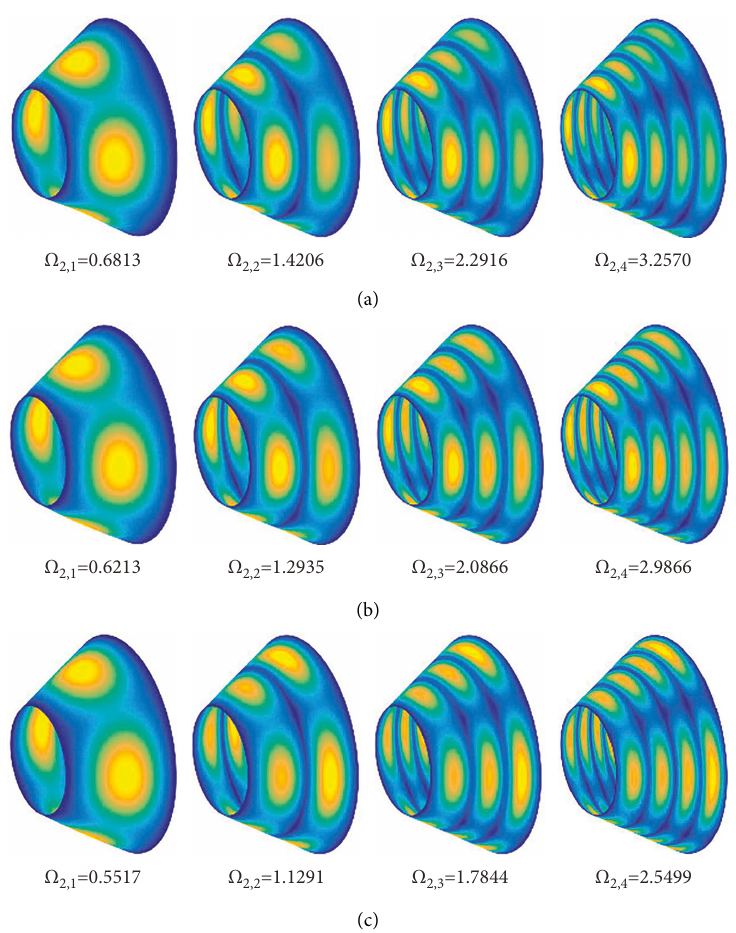
Figure 10: Mode shapes of laminated composite conical shell with variable thickness, (a) α � − 0.5, (b) α � 0, and (c) α � 0.5.